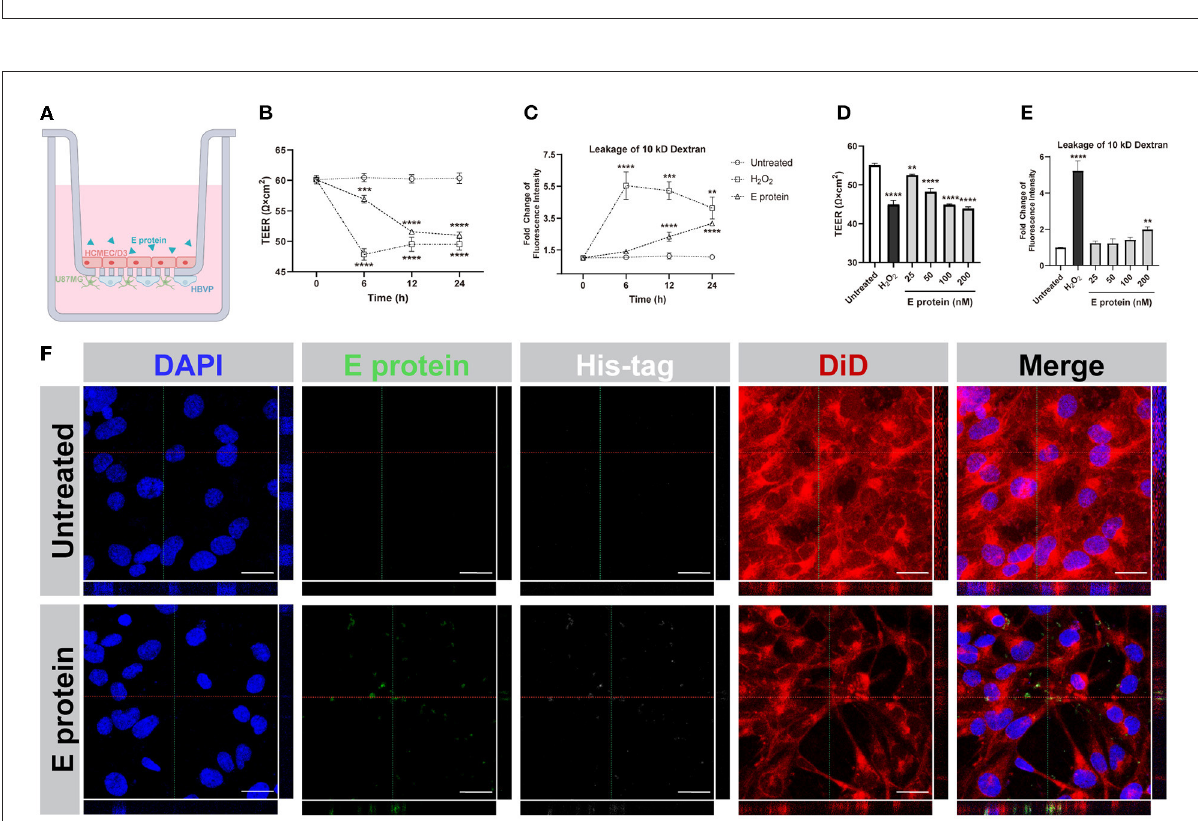
FIGURE2 SARS-CoV-2 envelope protein crosses and impairs the BBB model. (A) Schematic showing the various components of the in vitro BBB model. (B) Time courses of TEER values from HCMEC/D3 monolayers exposed to the S2E protein (100nM). (C) Analysis of the permeability of HCMEC/D3 monolayers treated with 100nM S2E protein for various times. (D) TEER values of HCMEC/D3 monolayers treated with different S2E protein concentrations for 12h. (E) HCMEC/D3 monolayer permeability after exposure to a range of S2E protein concentrations for 12h. (F) Confocal top-down and cross-sectional views of the HCMEC/D3 monolayer. Scale bar = 20 µ m. The data shown are the mean ± SD of three independent experiments. ** p < 0.01, *** p < 0.001, **** p <